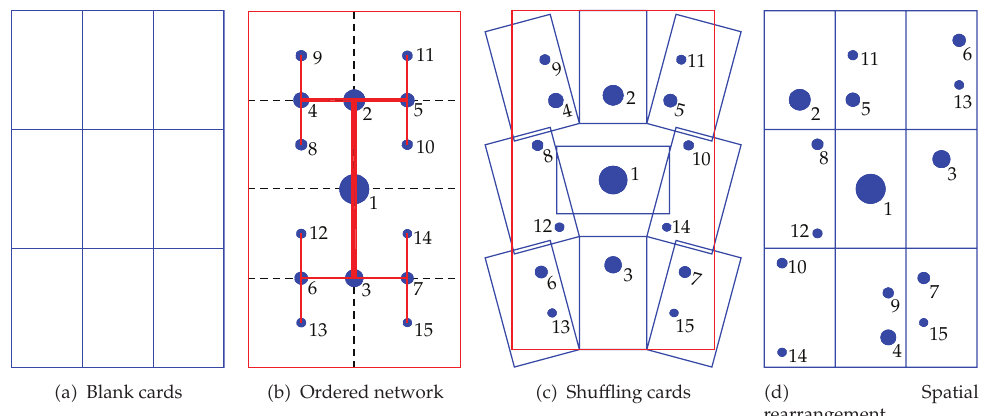
Figure 4: A sketch map of shu ffl ing cards of network of cities. (cid:6) Note: The sizes of cities conform to the rank- size rule, equation (cid:6) 2.9 (cid:7) . The numbers denote the rank of cities. The network in Figure 4 (cid:6) b (cid:7) is constructed according to the 2 n principle, but only the first four classes are shown here (cid:7)